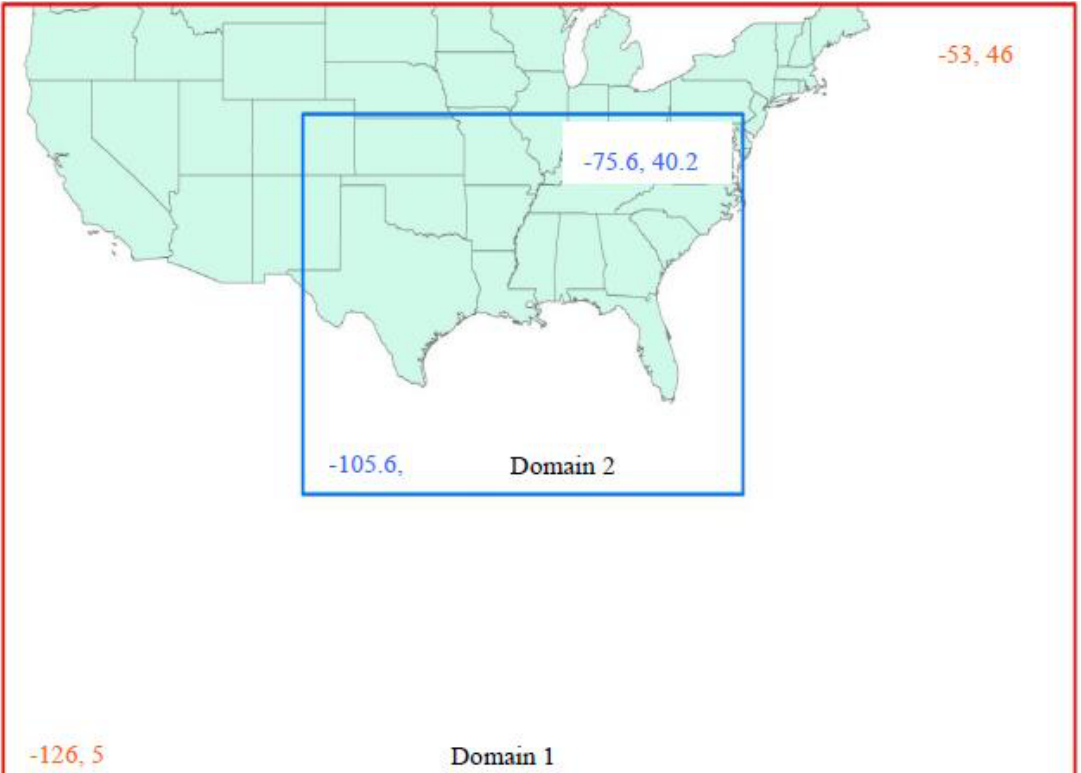
Figure 3. WRF model doubly nested domains fixed over the Gulf of Mexico and Florida region. Two domains of dimensions 81 × 47 and 100 × 67 are used with horizontal grid spacing of 90 km and 30 km